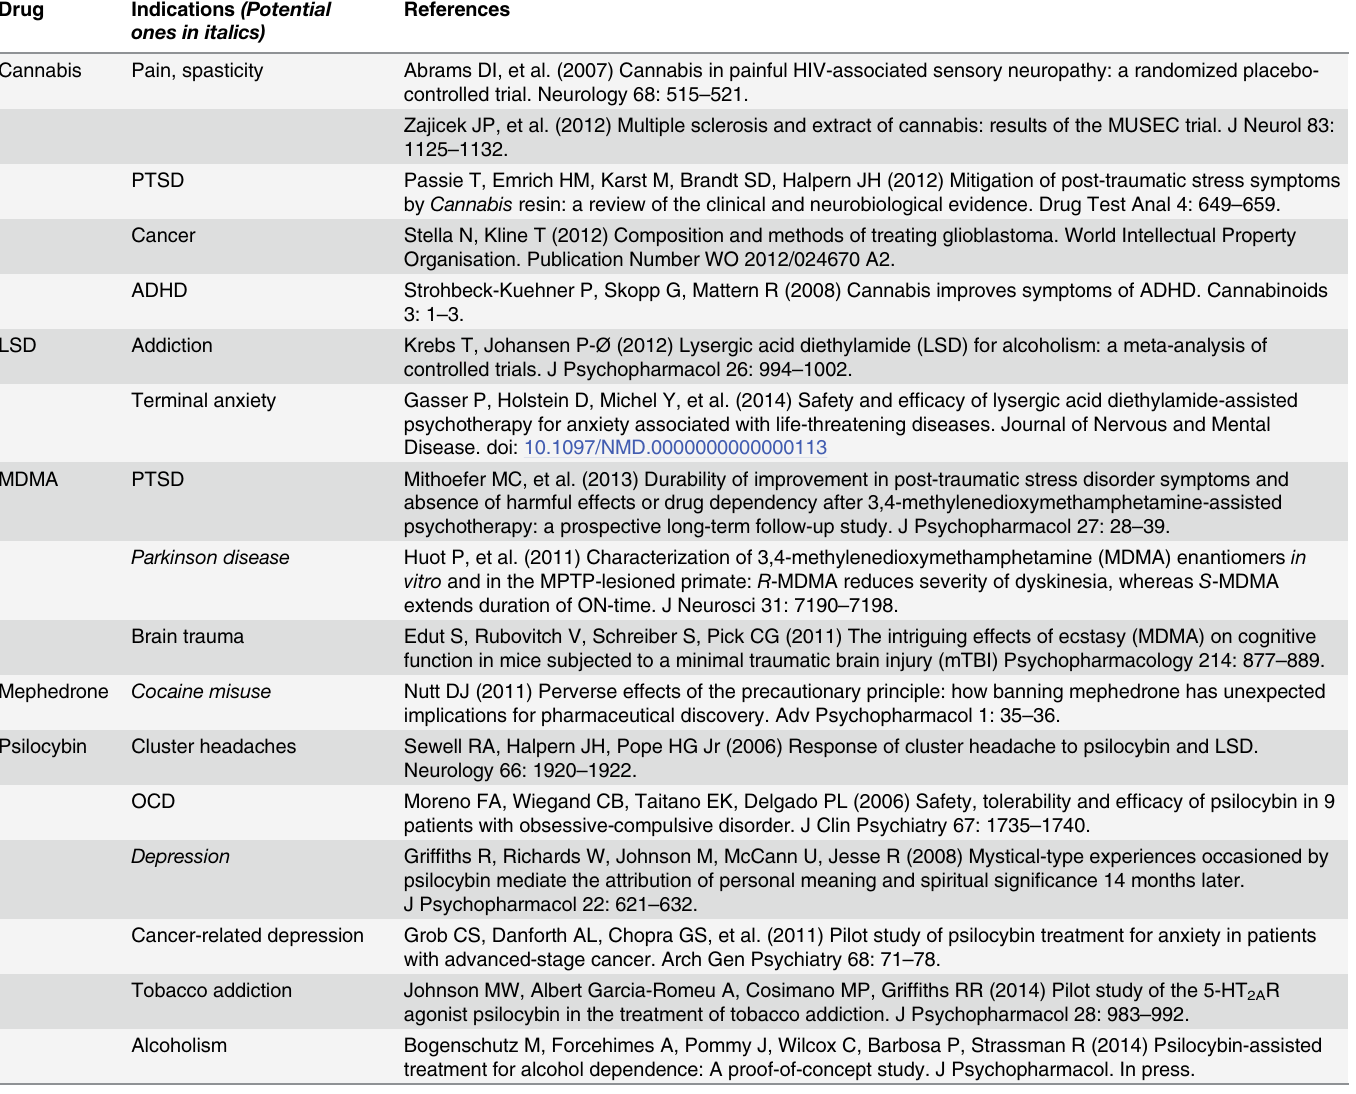
Table 2. Demonstrated and potential medical uses of “ illegal ” drugs. Drug Indications (Potential ones in